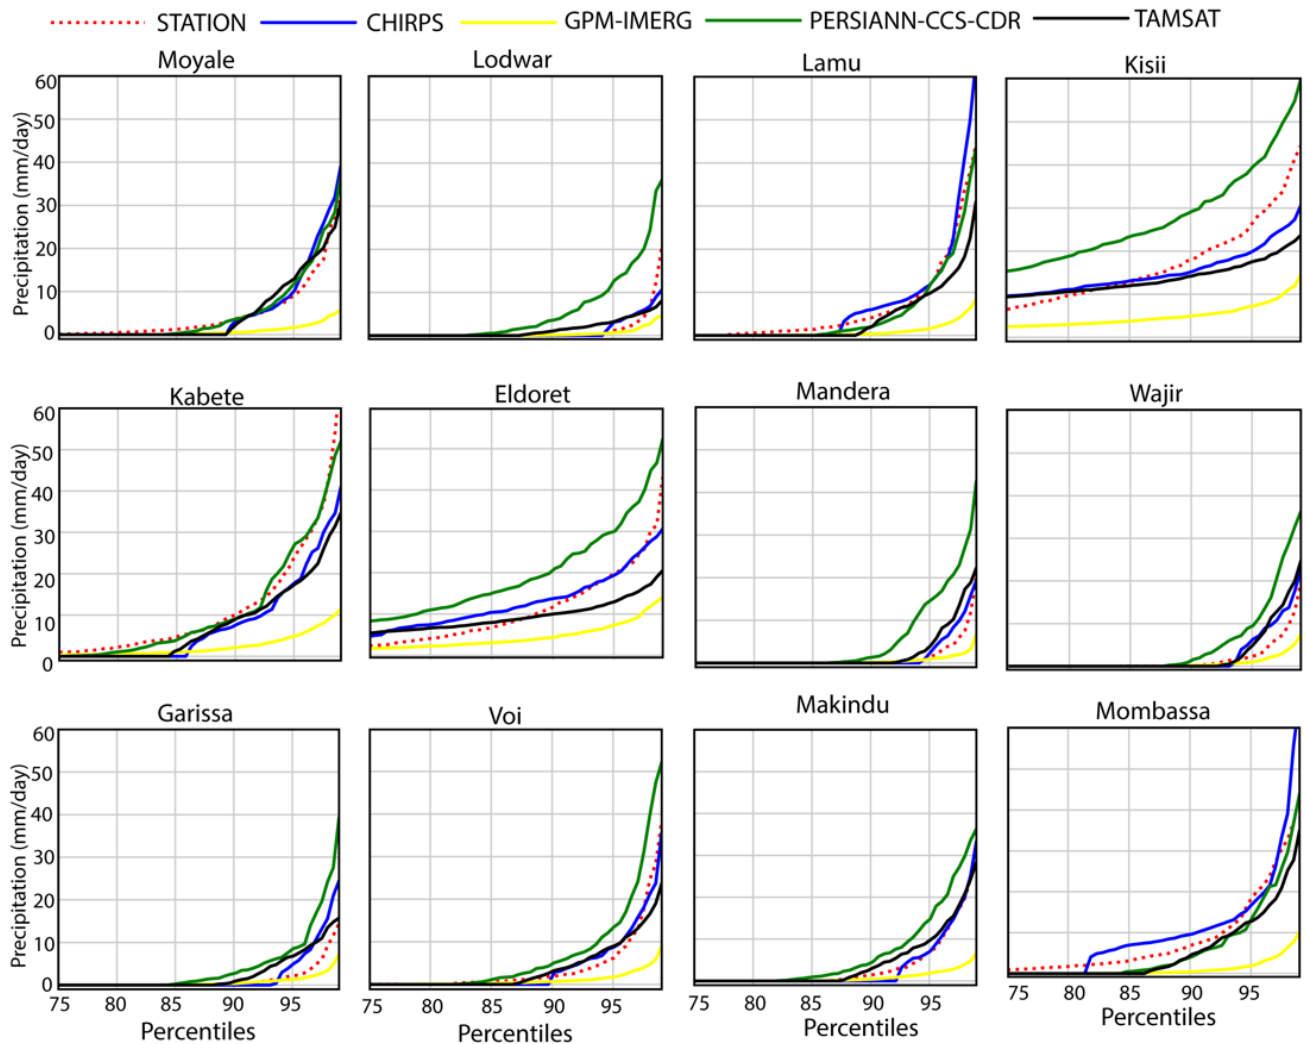
Figure 4. Observed and satellite estimated PRE from the 75th to the 99th percentile over Kenya at sampled stations.